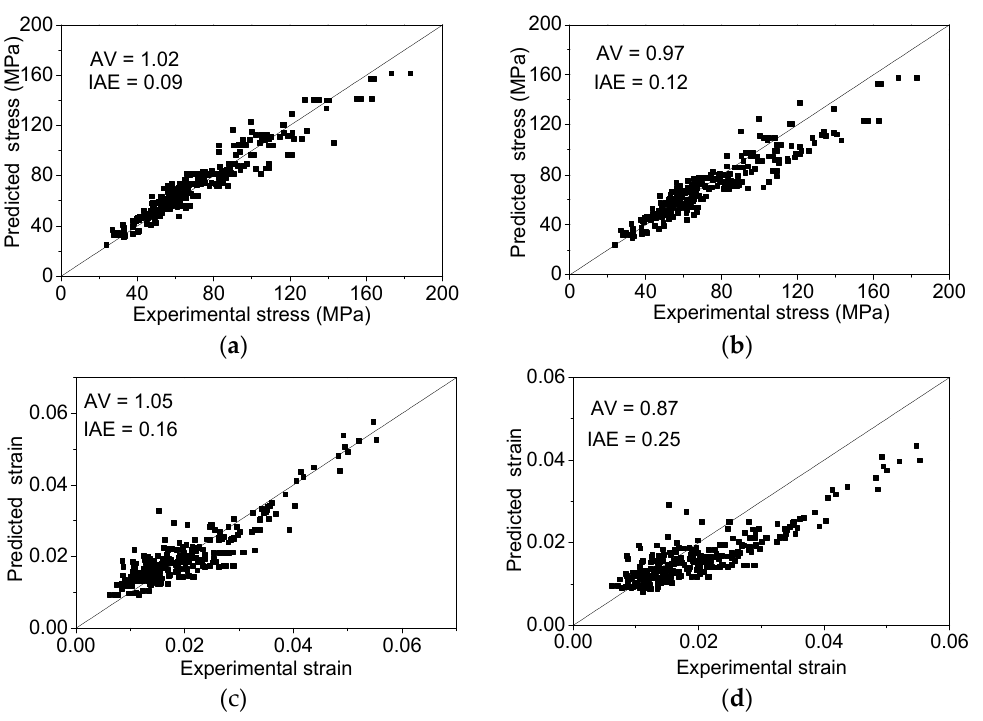
Figure 10. The performance of the ultimate stress and strain model for circular, square and rectangular columns. ( a ) Proposed ultimate stress model; ( b ) Wei and Wu’s ultimate stress model [19]; ( c ) proposed ultimate strain model; ( d ) Wei and Wu’s ultimate strain model [19].